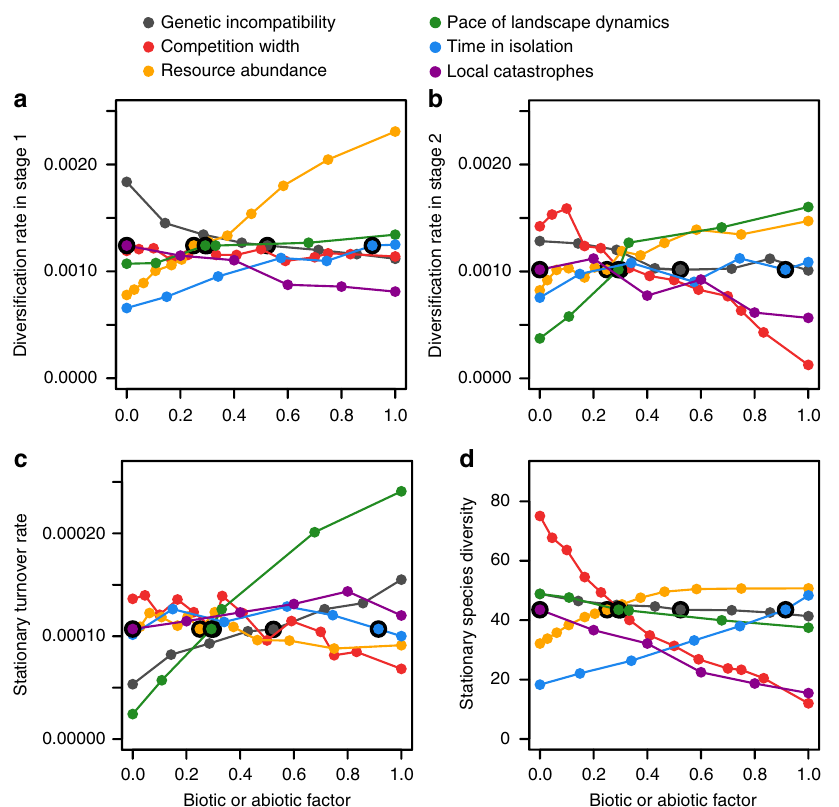
Fig. 2 Effects of different biotic and abiotic factors on macroevolutionary rates and species diversity. a Diversi fi cation rate in stage 1. b Diversi fi cation rate in stage 2. c Stationary turnover rate. d Stationary species diversity. Values are medians over 50 simulation replicates. See text and Methods for factor de fi nitions. The range of parameter values used for each factor was rescaled between 0 and 1, with 0 (respectively 1) corresponding to the smallest (respectively highest) parameter value used for that factor (see Methods). Black open circles correspond to default parameter values (Supplementary Table 1). Other parameter values as in Supplementary Table